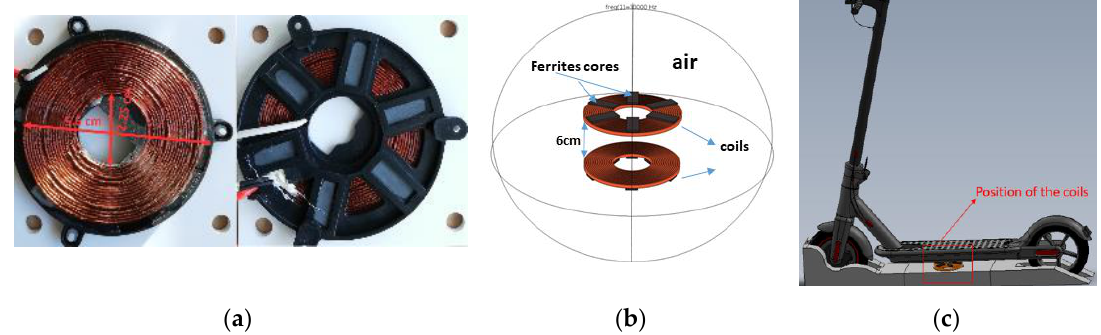
Figure 1. ( a ) Geometry of real coil; ( b ) COMSOL air domain and coils geometry; ( c ) position of the coils.